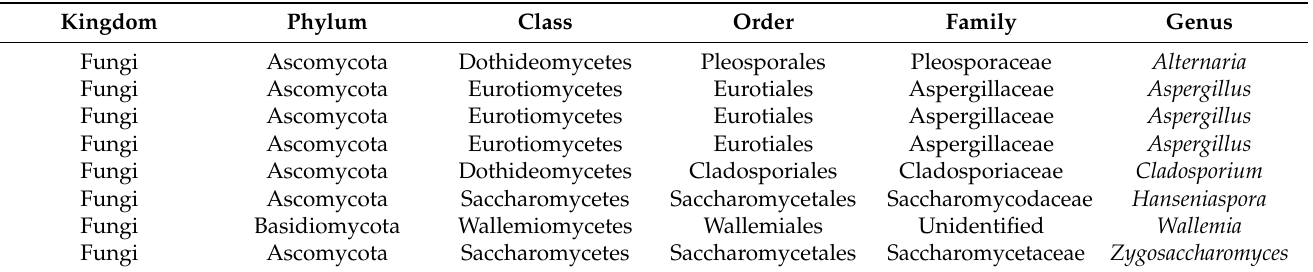
Table 1. Taxonomic data of fungi found in golden flaxseed via high-performance sequencing of the ITS intergenic